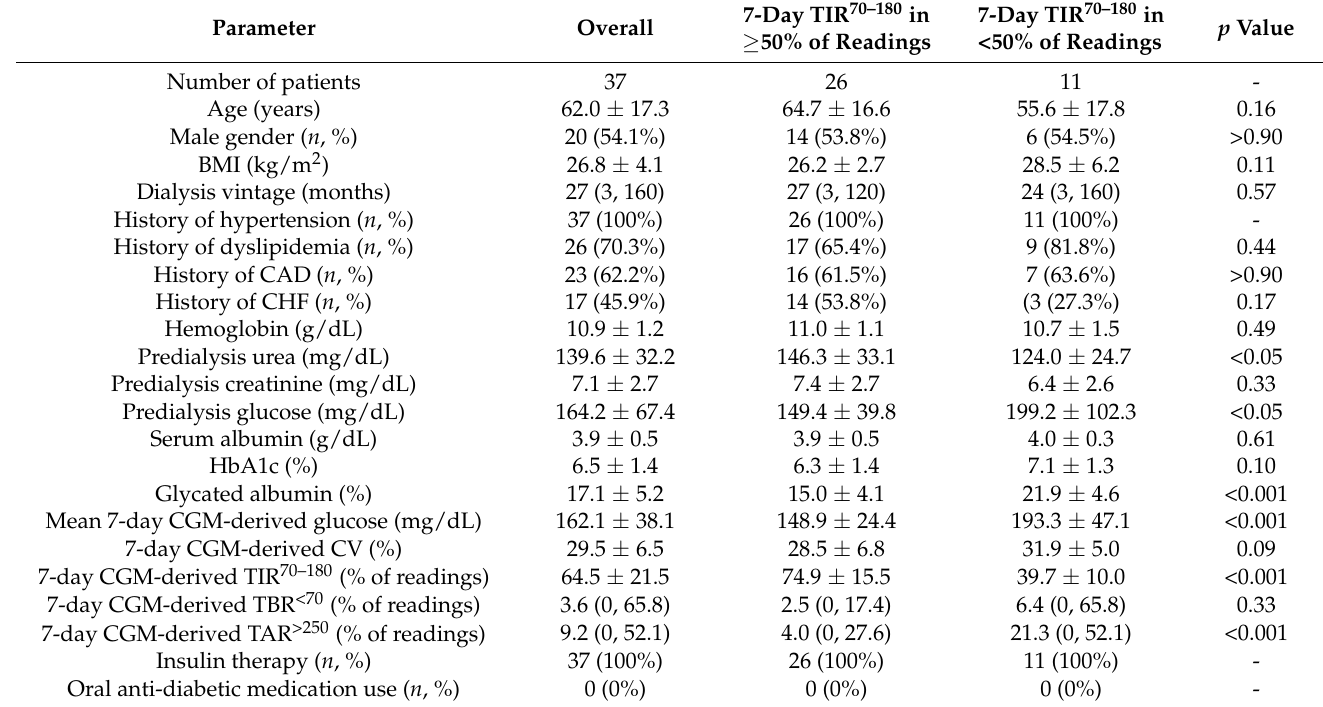
Table 1. Baseline characteristics of study participants.